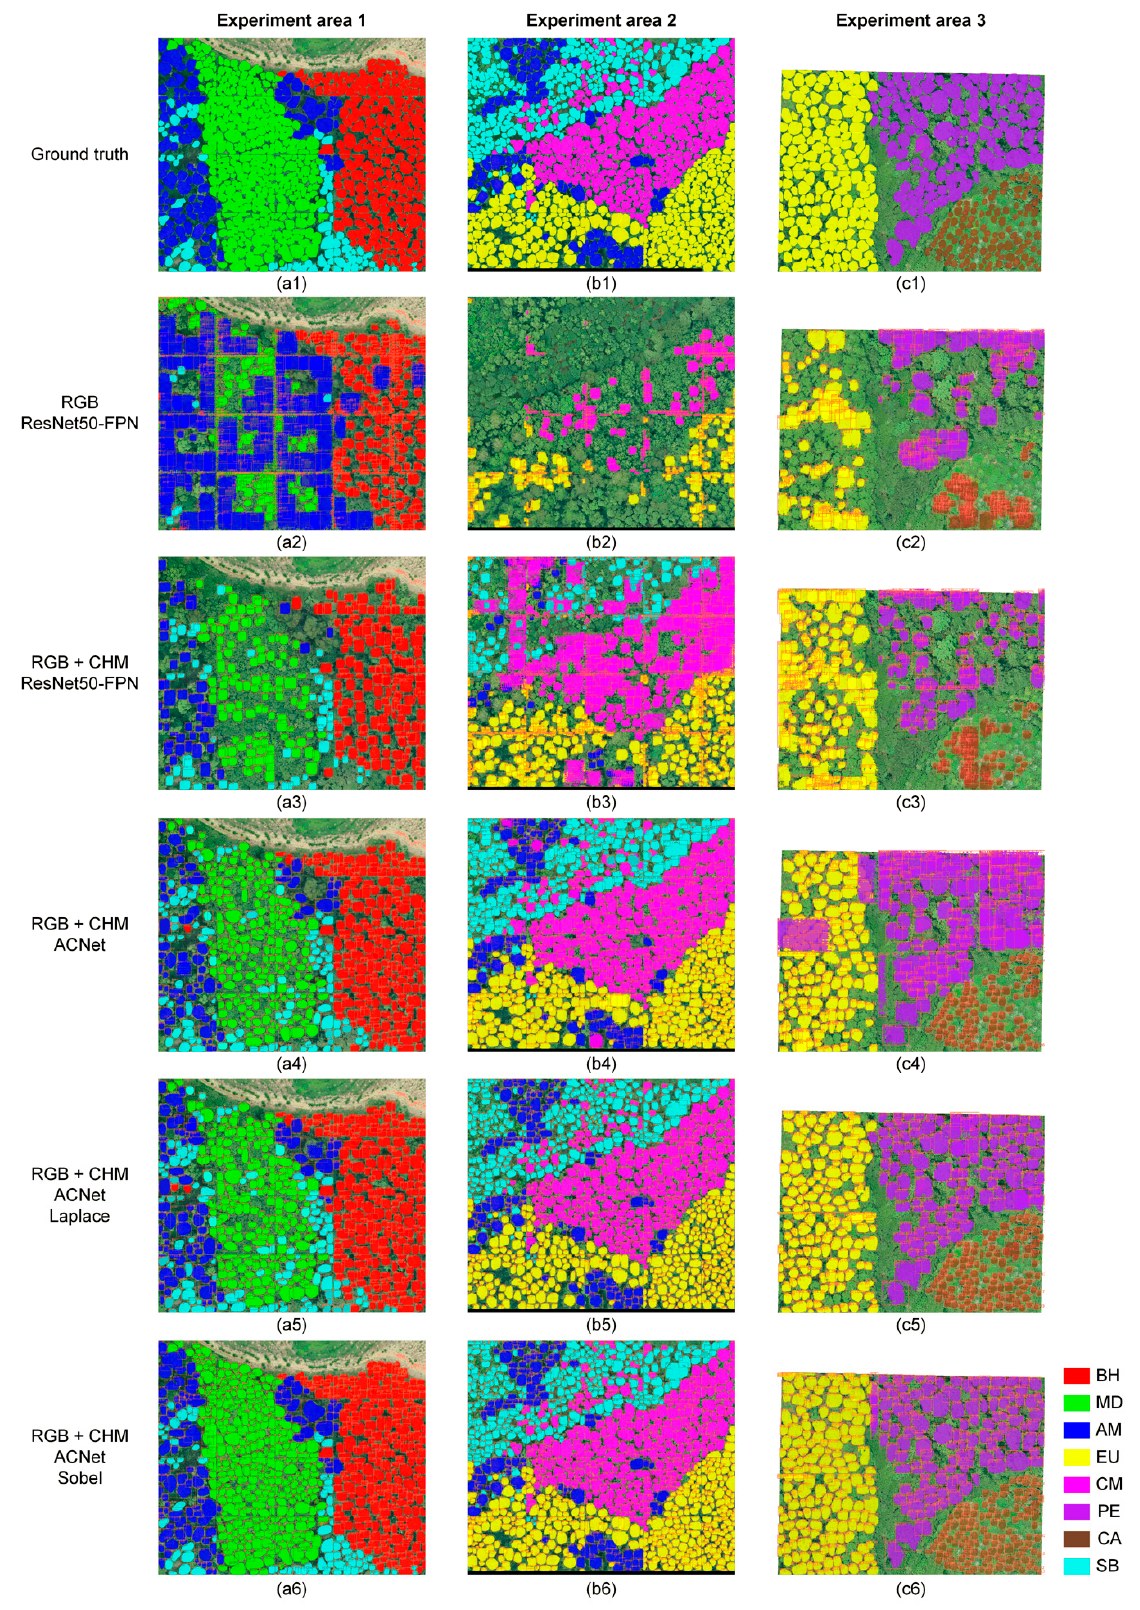
Figure 7. The results of individual tree species identification for three experimental areas by differ- ent experiment schemes. Different experiment schemes are shown on the left of the figure. ( a – c ) Experimental areas 1, 2, and 3, respectively.